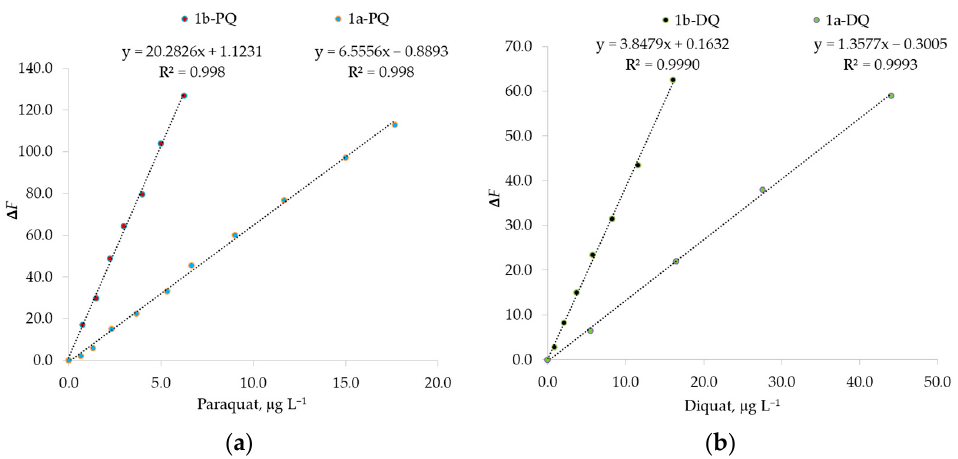
Figure 10. Fluorescence change ∆ F = F 0 − F of fluorophores 1a and 1b against ( a ) paraquat, PQ, or ( b ) diquat, DQ, concentrations in chloroform–methanol solution 1:1. F 0 indicates the fluorescence at [PQ] = 0 µ g L − 1 or [DQ] = 0 µ g L − 1 at 336 nm for naphthalene fluorophore 1a and at 416 nm for anthracene fluorophore 1b.